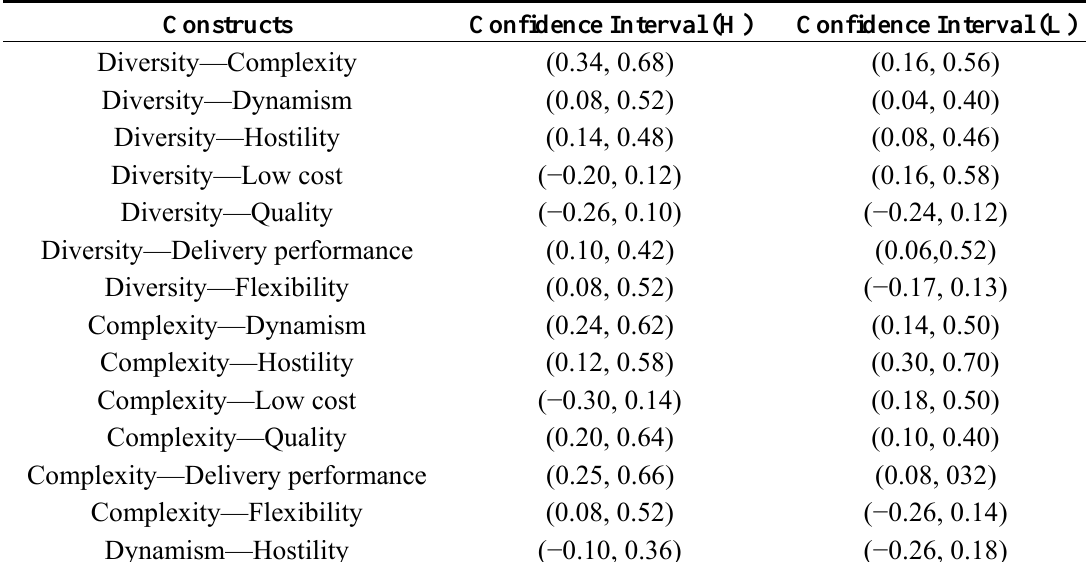
Table A4. Discriminant Validity